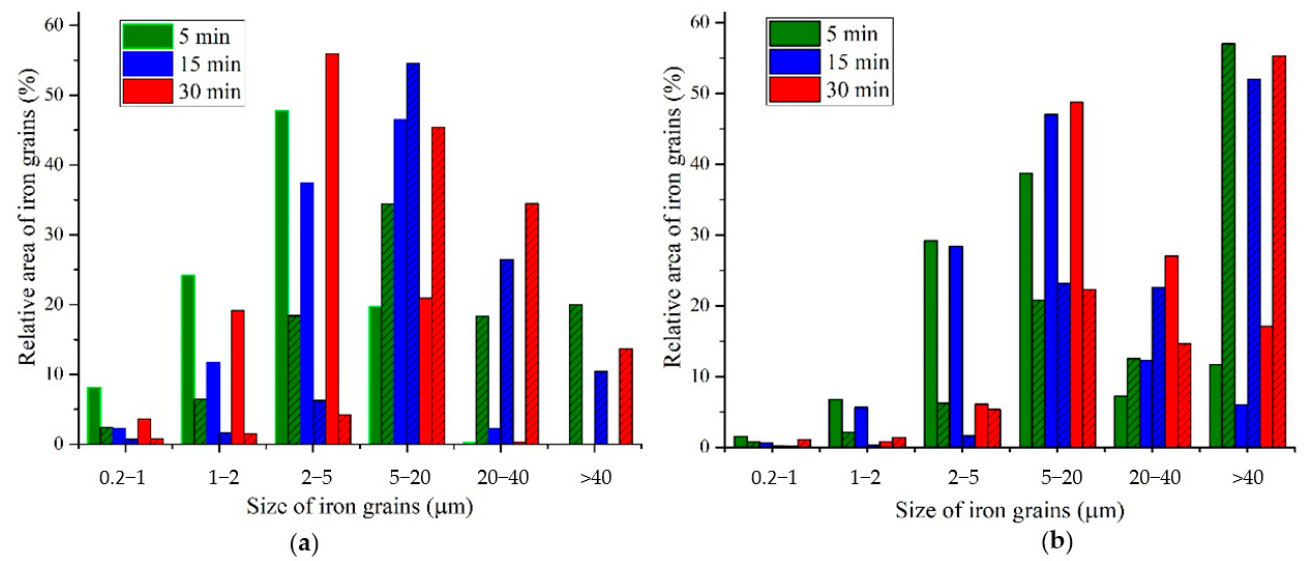
Figure 10. The microstructure of the roasted samples with 13.65% Na 2 SO 4 obtained after carbothermic reduction at 1000 °C ( a – c ) and 1200 °C ( d – f ) for 5, 15 and 30 min, respectively (×250 magnification).